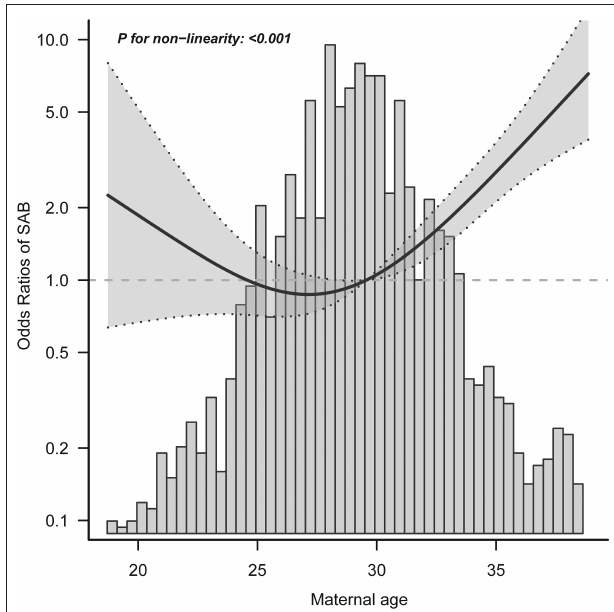
FIGURE 2 | Exposure-response relationship between maternal age and spontaneous abortion. SAB, spontaneous abortion; CI, confidence interval. Data were fit by a logistic regression model based on restricted cubic splines. Maternal age was entered as continuous variable. Data were adjusted for maternal ethnicity, maternal education, maternal occupation, maternal income, maternal body mass index, parity, folic acid supplementation, multivitamins supplementation, and medication use. The gray area represents the 95%